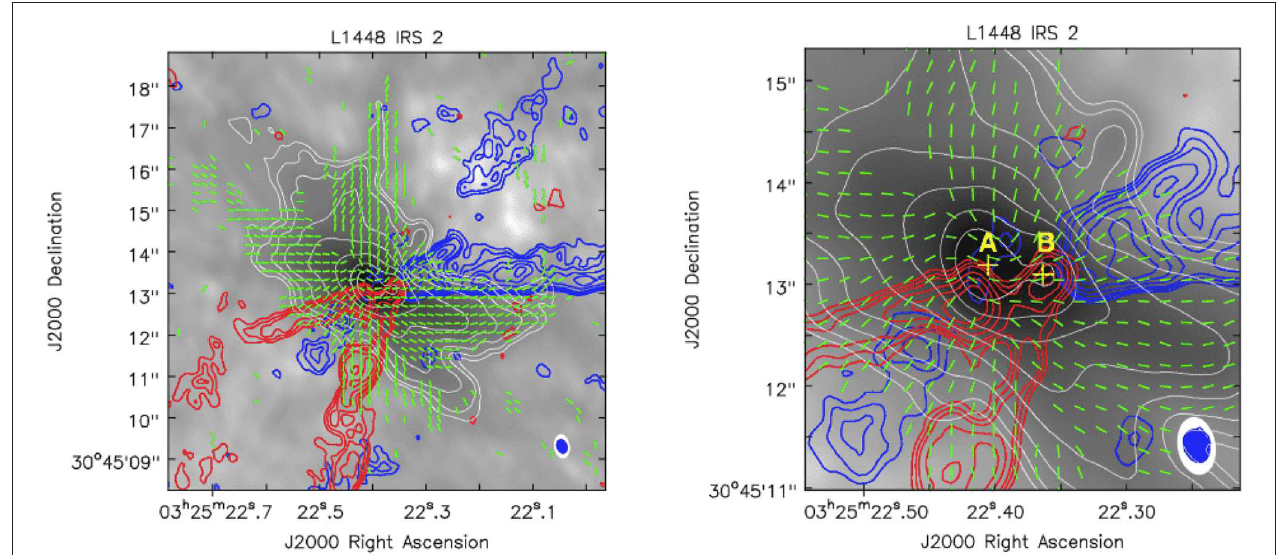
FIGURE 3 | Magnetic field morphology around L1448 IRS 2. (Left) The green vectors indicate the inferred magnetic field direction. The gray scales and white contours present the total intensity distribution with levels of 2 to 129 times 0.1 mJy beam. The blue and red contours are CO 2-1 intensity distributions integrated in velocity ranges of -8:0 to 2.0 and 7.5 to 16.0 km s − 1 , respectively. (Right) Zoomed-in central region. The synthesized beams of the CO and the continuum data are marked in the bottom right corner in blue and white, respectively. From Kwon et al. (2019) reproduced with permission c (cid:13)